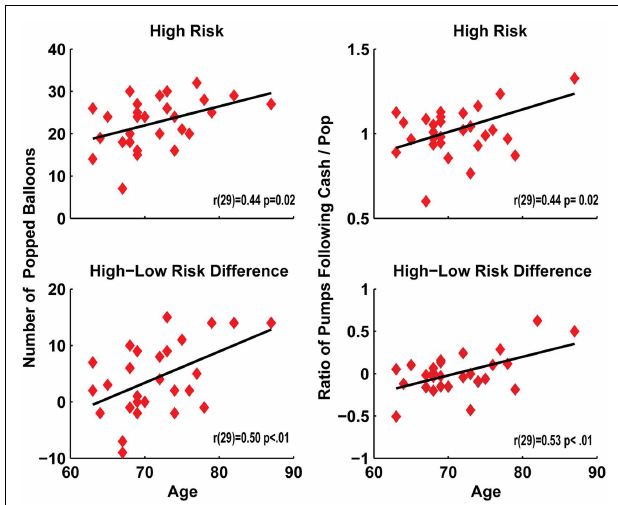
FIGURE 3 |Age correlated with the number of popped balloons and post-cash: post-pop ratio of the number of pumps in both the high risk condition, as well as the increase between the high and low risk